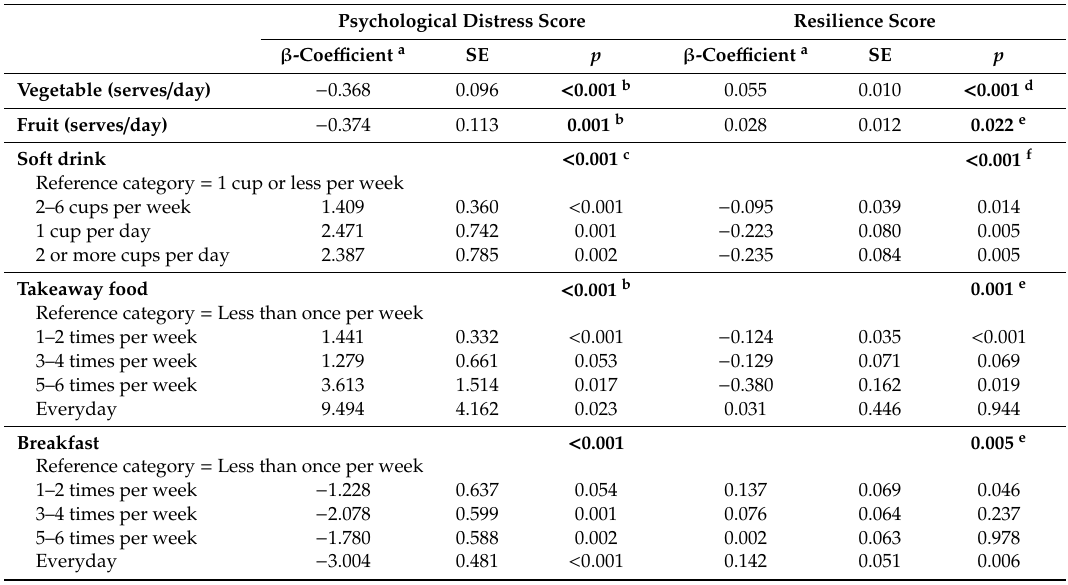
Table 3. Linear regression results of psychological distress and resilience scores with dietary intake in a sample of Australian university students ( n = 2710). Psychological Distress Score Resilience